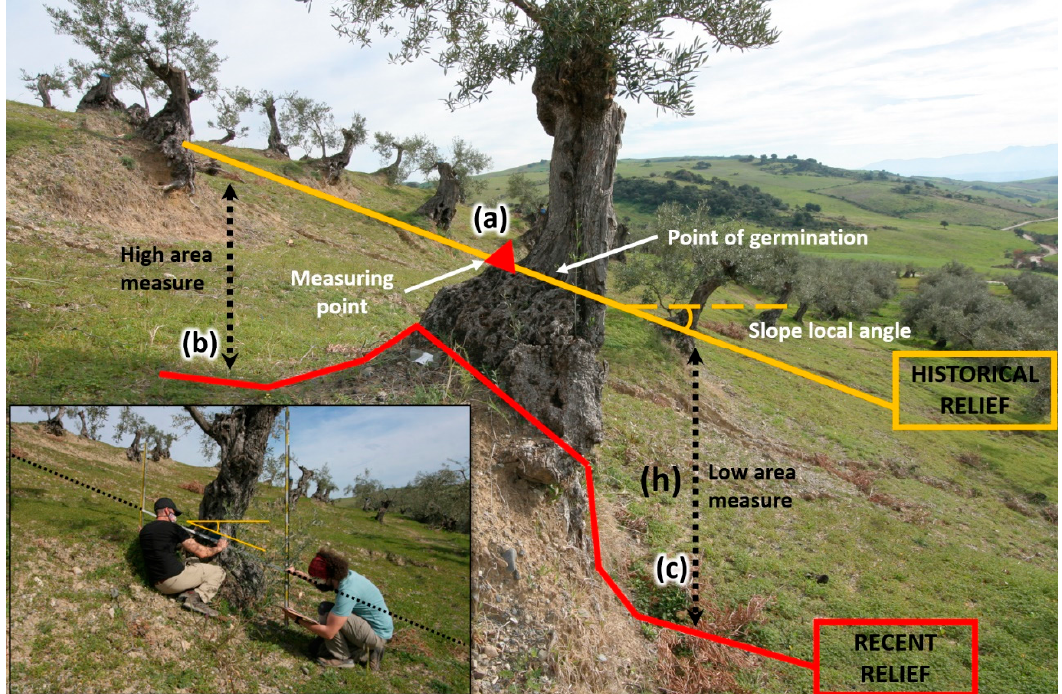
Figure 2. A mound formed by erosion around a tree in the “High Fontarron.” The historical relief of the soil is indicated by the yellow line reconstructed from the germination point ( a ). The red line indicates the position of the recent relief. The difference between the two surfaces corresponds to the truncation of the eroded soil profile (h), represented by a dashed black line. Hence, ( b ) and ( c ) indicate the upper and bottom part of the mounds, respectively. The measurement of (h) was taken at the top and the bottom of the mound. Slope gradients were determined using a digital clinometer (slope local angle is also depicted).